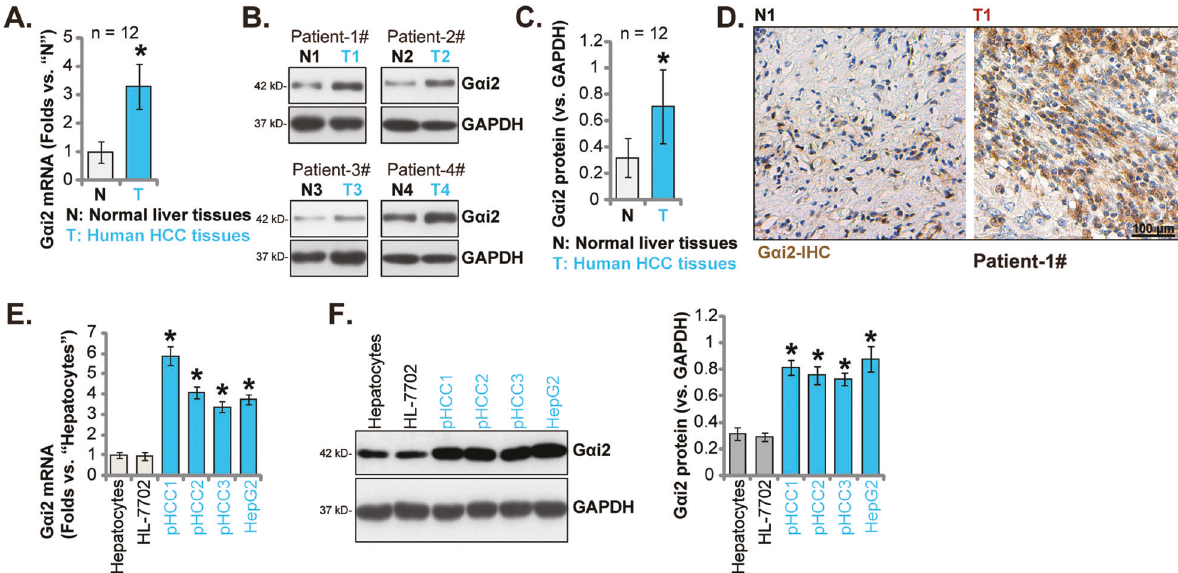
Fig. 2 G α i2 is overexpressed in local human HCC tissues and different HCC cells. Expression of G α i2 mRNA ( A ) and protein ( B , C ) in HCC tumor tissues ( “ T ” ) and matched adjacent normal liver tissues ( “ N ” ) of twelve local primary HCC patients was shown, with results quanti fi ed. The representative G α i2 IHC images of HCC tumor tissue ( “ T ” ) and matched adjacent tissue ( “ N ” ) of Patient-1 were shown ( D ). G α i2 mRNA ( E ) and protein ( F ) expression in patient-derived primary HCC cells ( “ pHCC1/pHCC2/pHCC3 ” , derived from three different patients), immortalized HepG2 cells, HL-7702 hepatocytes or the primary human adult hepatocytes ( “ Hepatocytes ” ) was shown, with results quanti fi ed. The data were presented as mean ± standard deviation (SD).* P < 0.05 vs. “ N ” tissues/ “ Hepatocytes ” . Scale bar = 100 μ